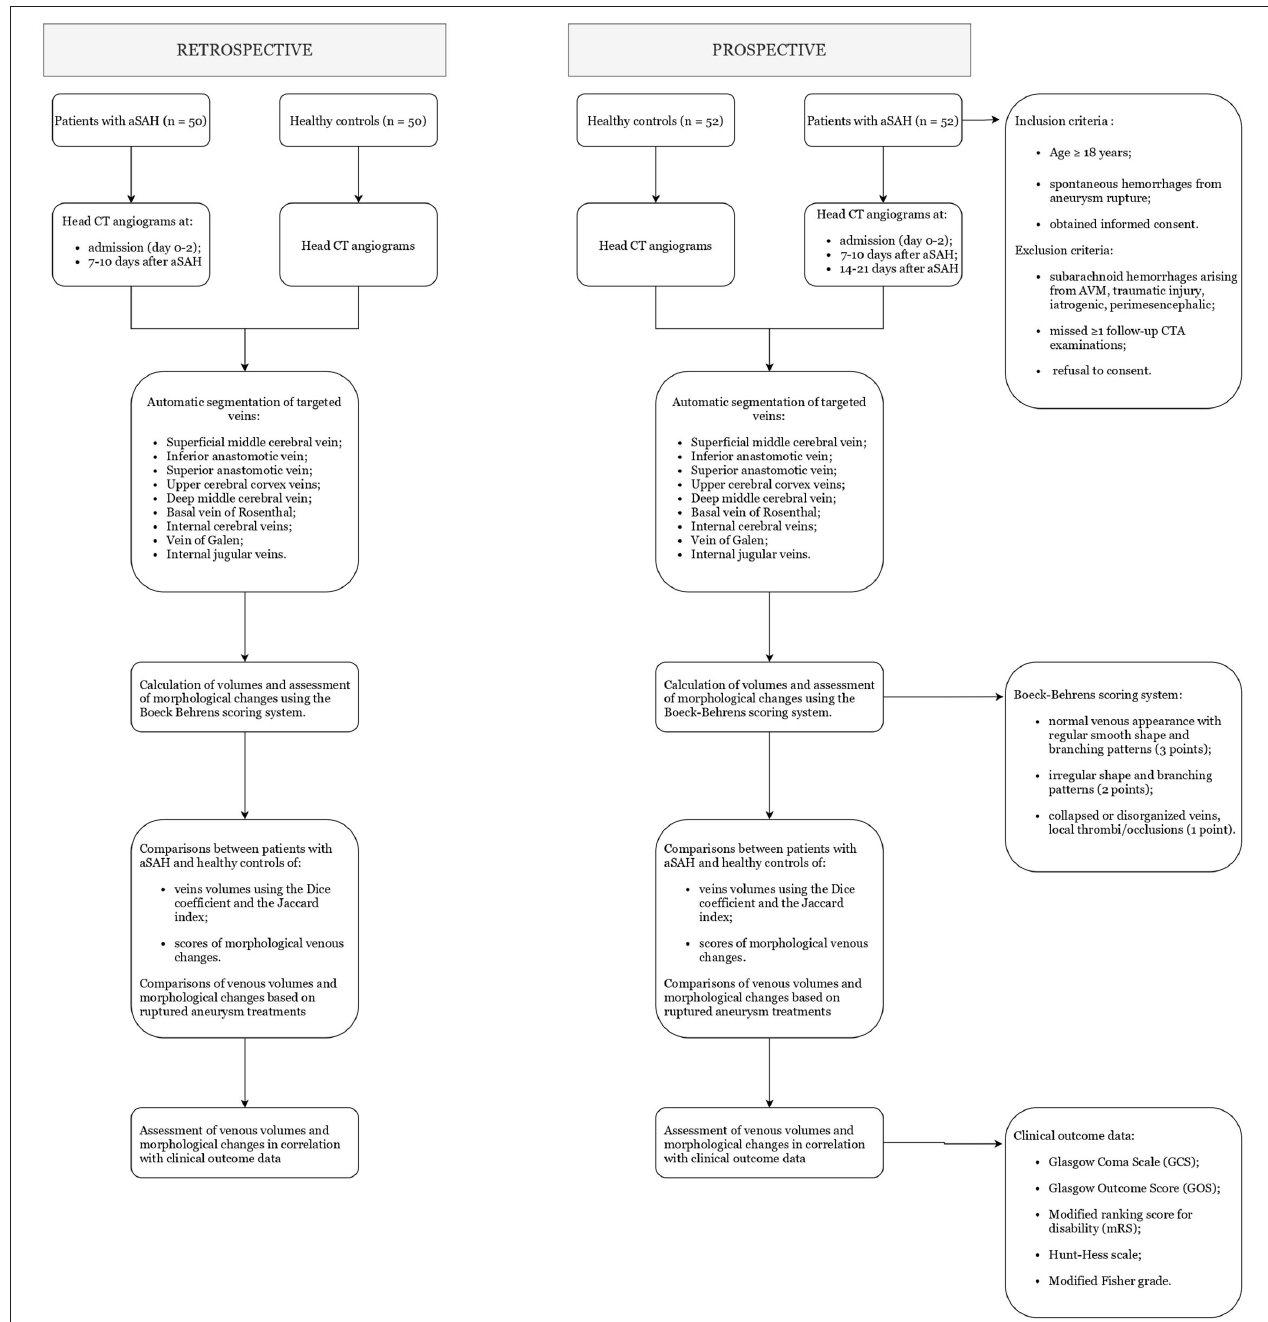
FIGURE 1 | Flow chart of the study